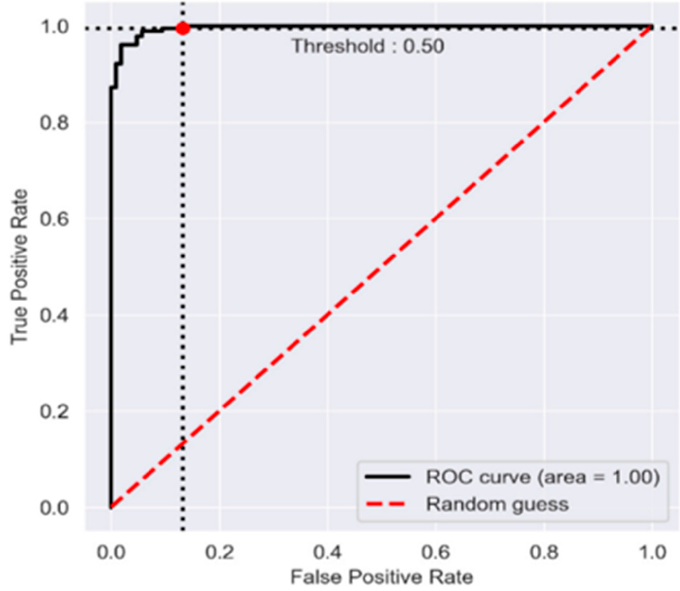
Figure 4. Receiver Operating Characteristic (ROC).